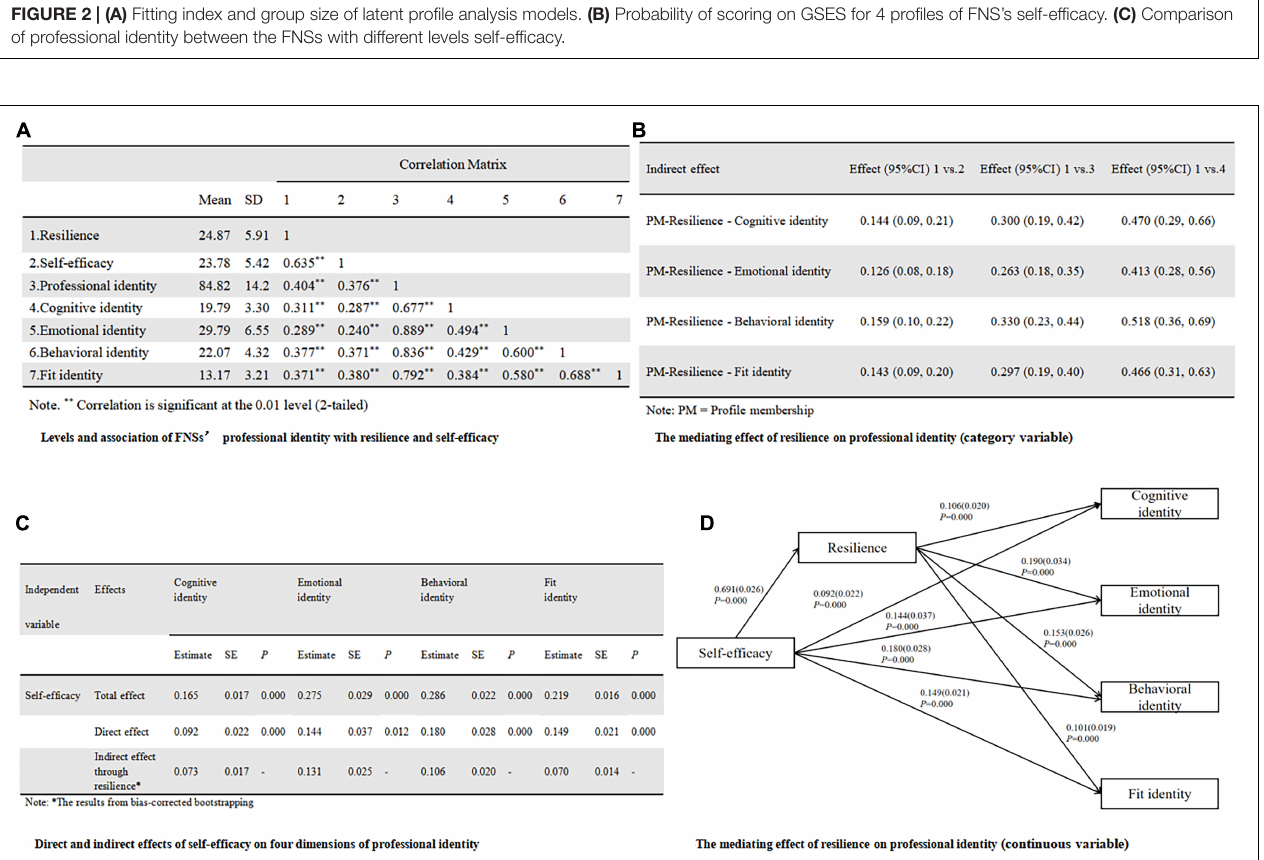
FIGURE 3 | (A) Levels and association of FNS’s professional identity with resilience and self-efficacy. (B) The mediating effect of resilience on Professional identity (category variable). (C) Direct and indirect effects of self-efficacy on four dimensions of professional identity. (D) The mediating effect of resilience on professional identity (continuous